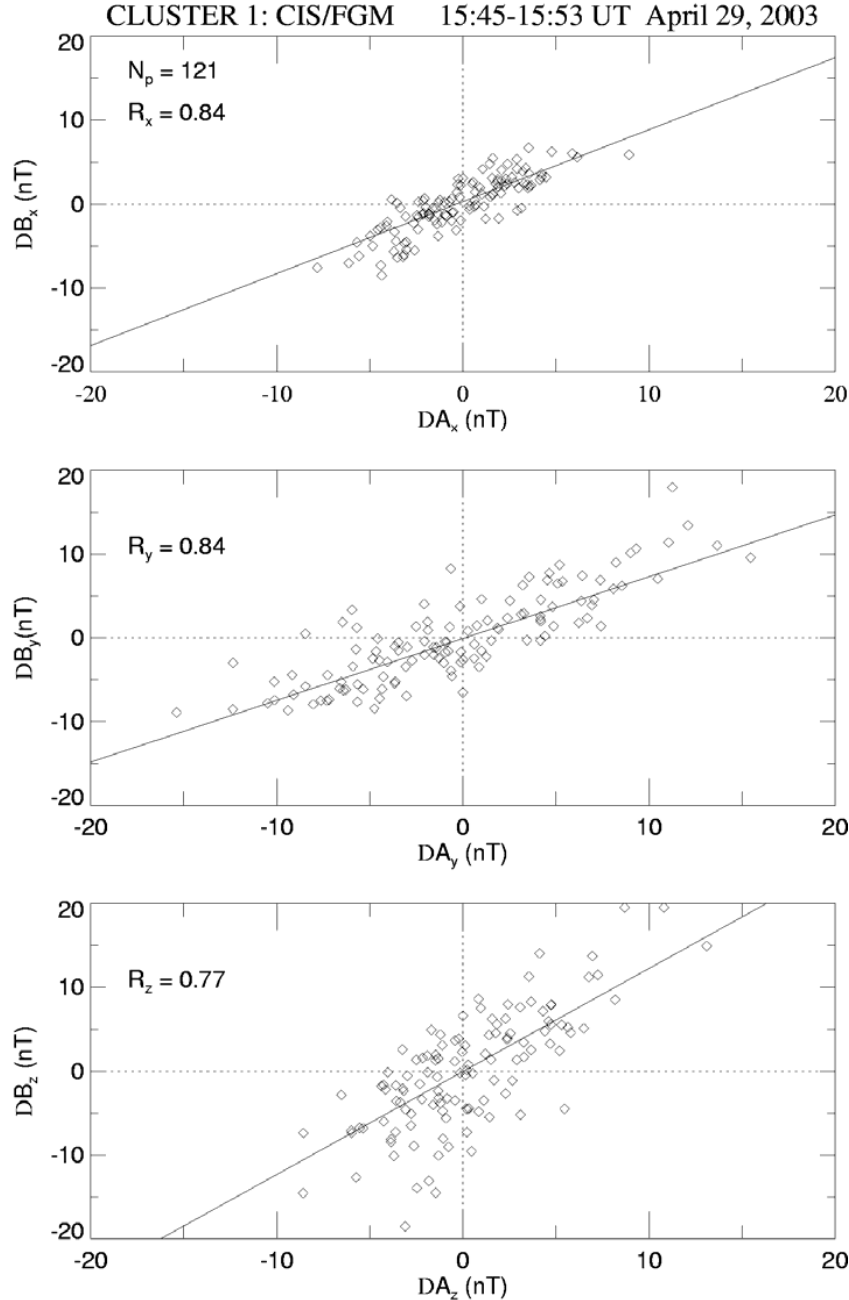
Fig. 13. Scatter plots checking the Wal´en relationship for the interval from 15:45 to 15:53 UT. Cluster 1 FGM and CIS data are shown for each of the components of the change in the magnetic field versus the change in the abscissa. The abscissa is defined as 1A = ( 4 πρ) 1 / 2 1V . The slope of the linear regression is noted in each component